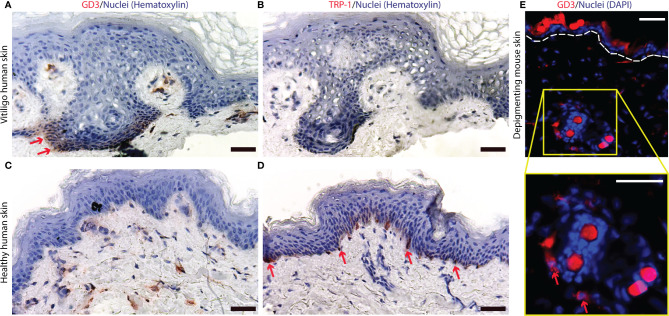
Ganglioside D3 is expressed in depigmenting skin of human and mouse origin. (A) Expression of GD3 and (B) a lack of melanocytes, as represented by an absence of TRP-1+ staining, were found in human depigmenting epidermis from perilesional patient skin. Whereas (C) limited GD3 expression and (D) abundant TRP-1 expression are shown in healthy control skin. (E) In depigmenting mouse skin, GD3 expressing cells were observed around hair follicles and in proximity to the epidermis. Representative staining of GD3 expressing cells is shown in red with nuclei in blue, around autofluorescent mouse hairs (Scale bar = 50μm).